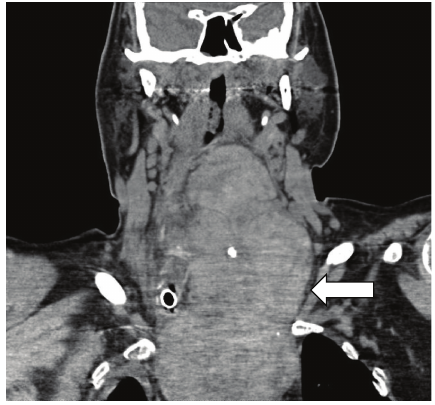
Figure 3: Large cervicomediastinal mass (coronal view).